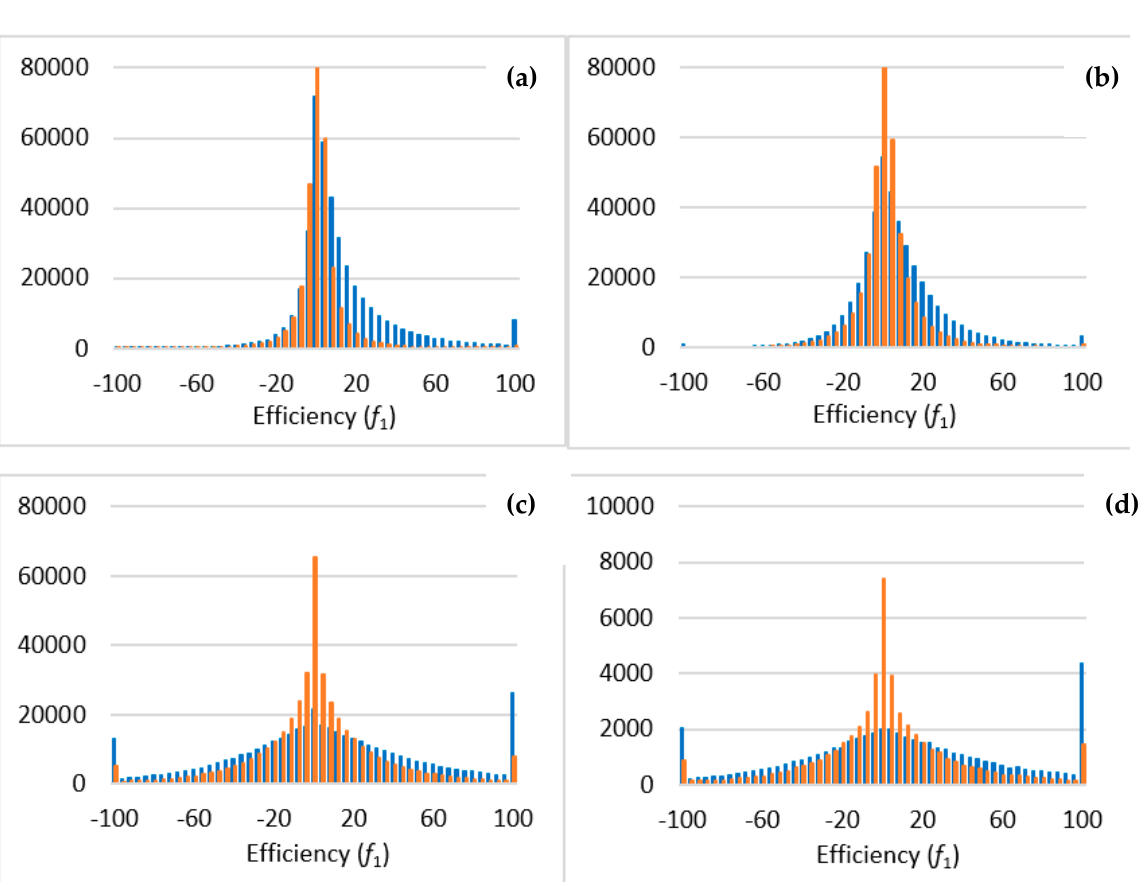
Table 2. Impact of metadata use on the upper tail of the probability distribution of residual errors after homogenization.